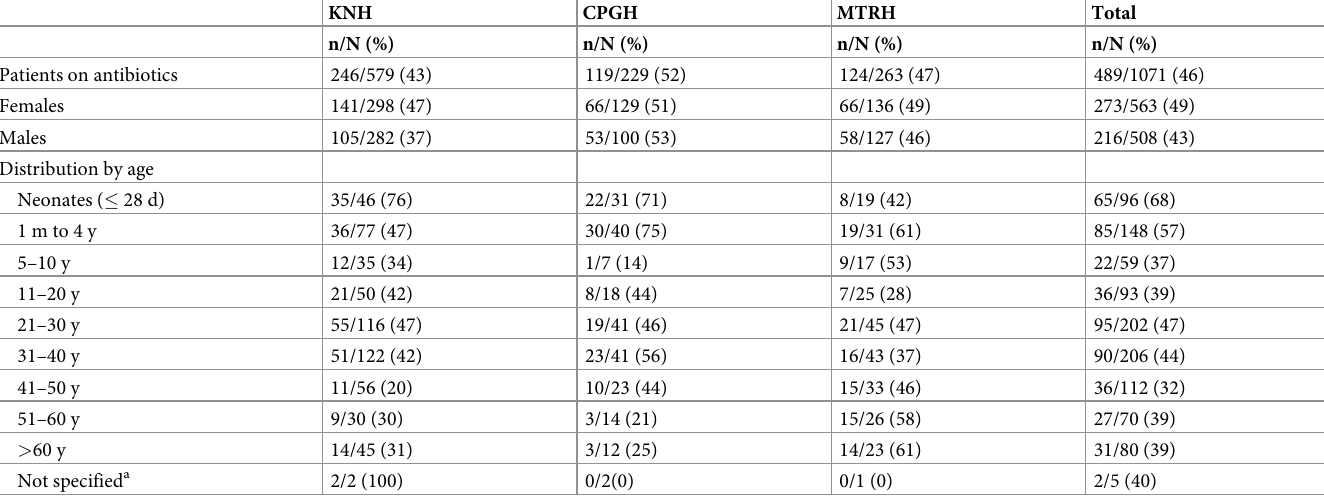
Table 2. Distribution of antibiotic use by patient sex and age at Kenyatta National Hospital (KNH), Coast Provincial General Hospital (CPGH) and Moi Teaching and Referral Hospital (MTRH), 2017–2018, Kenya. KNH